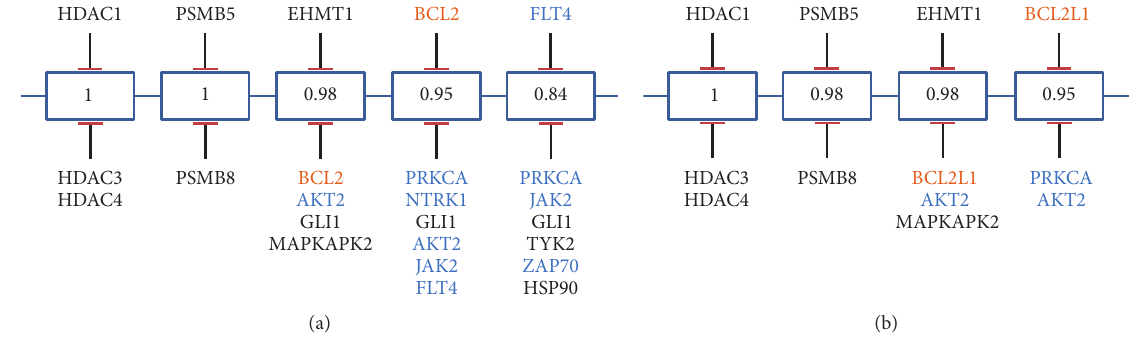
Figure 3: Probabilistic Target Inhibitor Map (PTIM) model of the PCB209 xenograft-derived chemical screen. Orange text indicate targets inhibited by ABY-737; blue text indicates targets inhibited by midostaurin. (a) Pediatric preclinical testing initiative (PPTI) 60 chemical screen informed PTIM. (b) RNA-seq +PPTI chemical screen informed PTIM. PTIM models were used to guide a portion of the larger PDX in vivo trial shown in Figure 2. Numbers listed in the individual boxes represent scaled sensitivity values, 1 being a highly sensitive target combination and 0 being an ineffective/resistant target